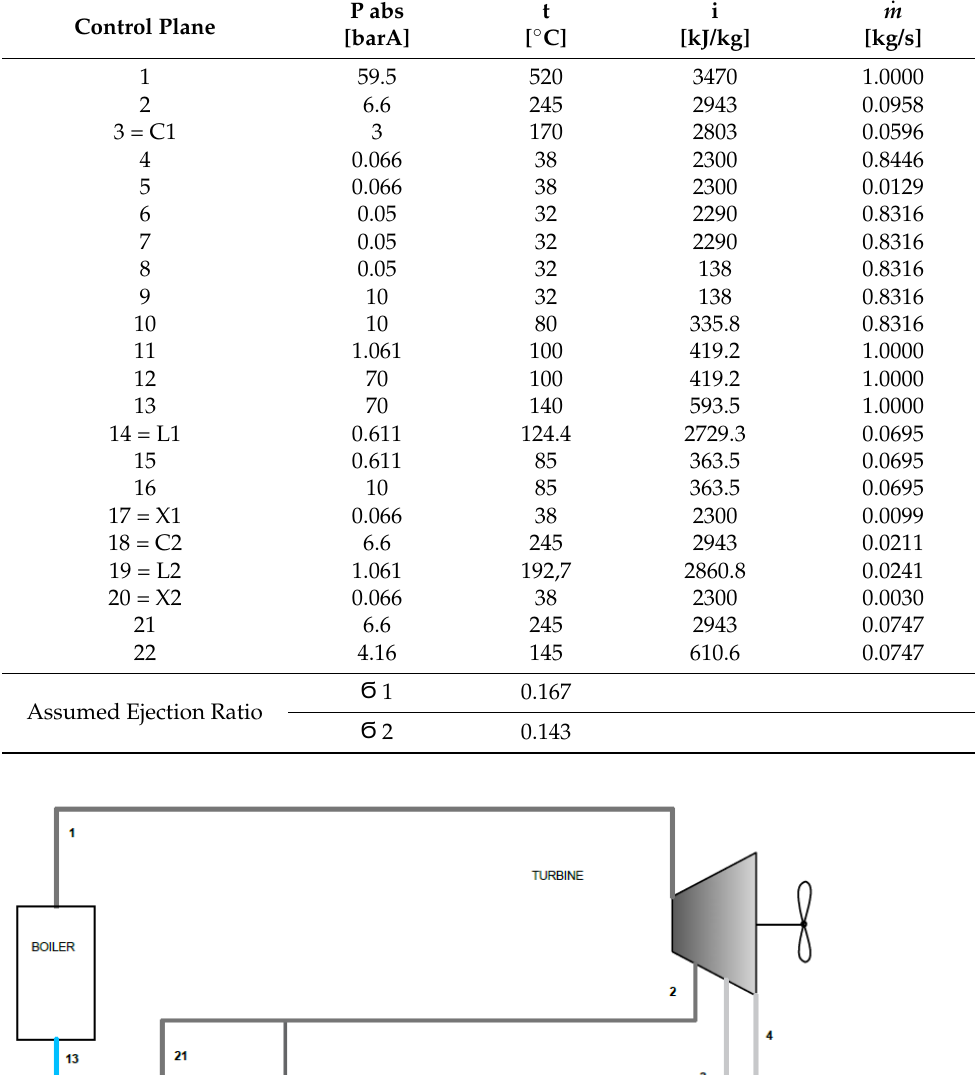
Table 4. Thermodynamic parameters of the working fluid in the control planes of the regenerative cycle with single-stage injectors.